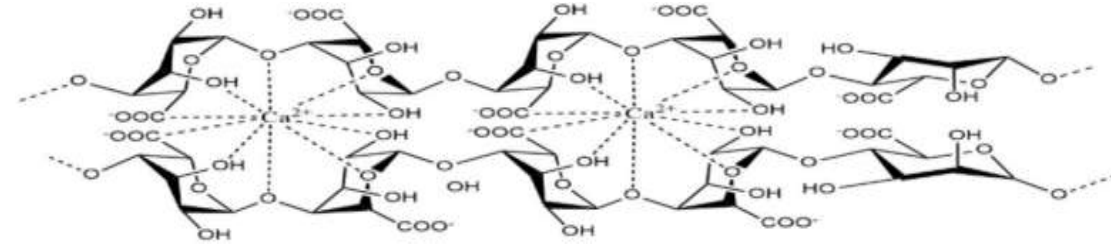
Figure 4. Egg-Box Alginate Cross-linking with CaCl